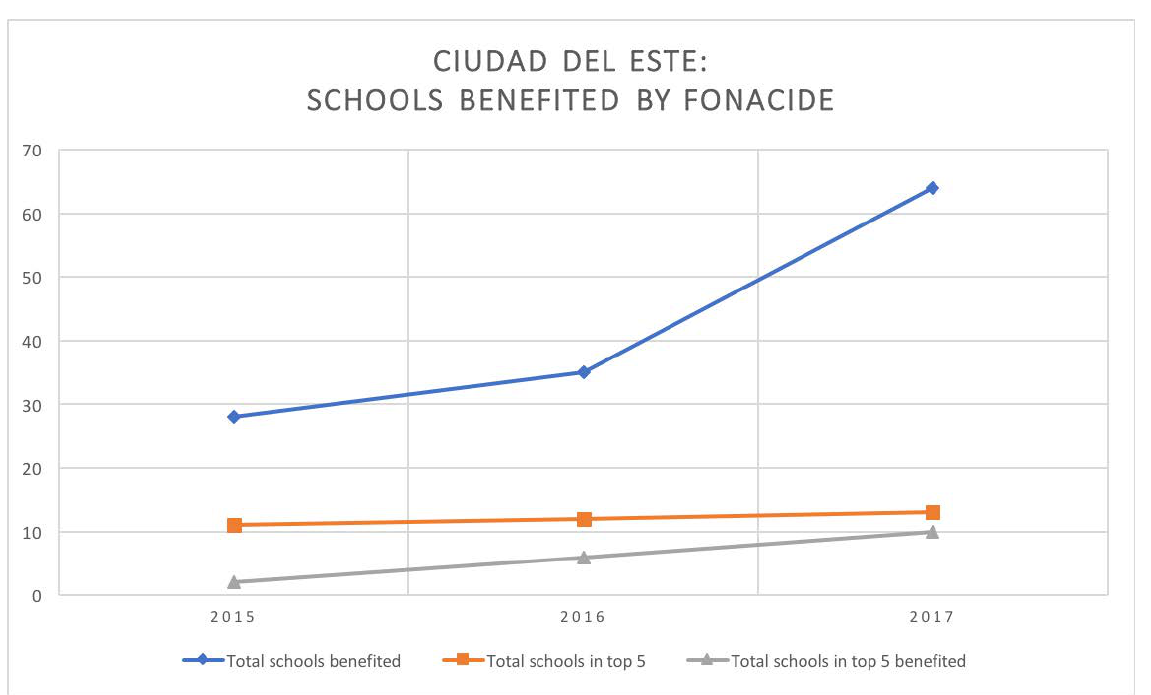
Source: Author’s elaboration. Figure 9: Ciudad del Este: Schools Benefited by FONACIDE